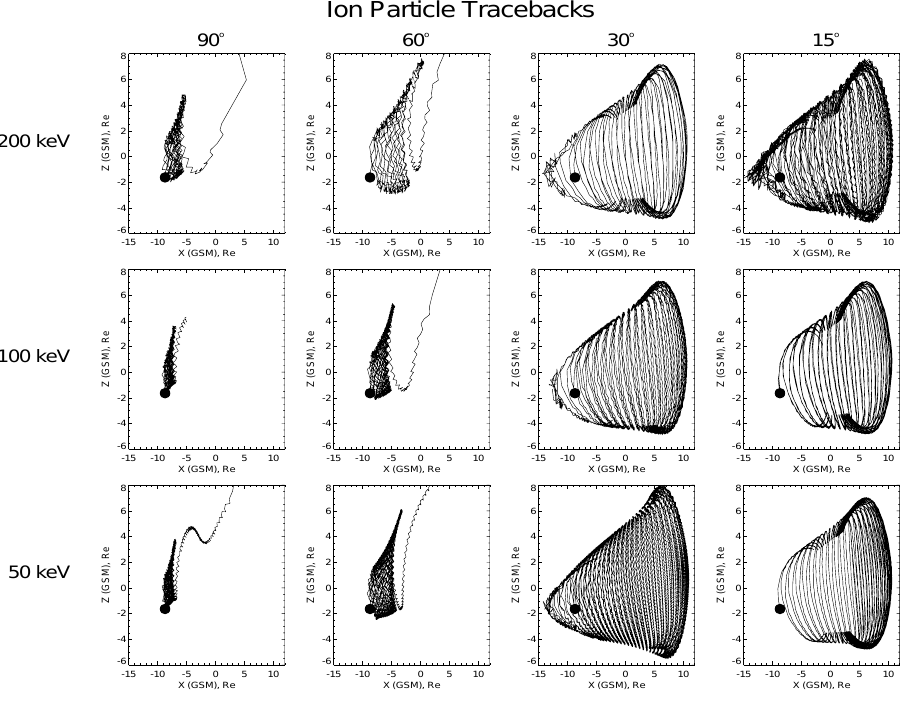
Fig. 14. Similar as in Fig. 13, but plotted in the X-Z plane.